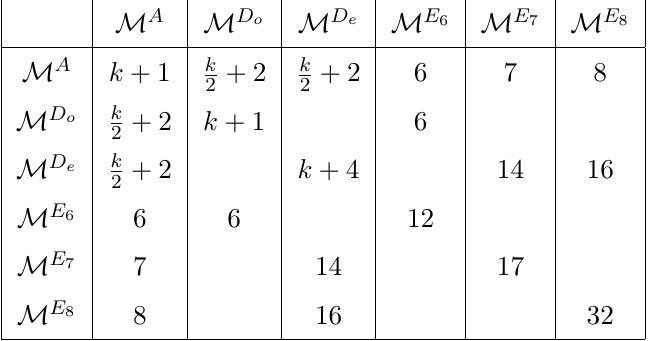
Table 3 . Traces of products of modular invariants for the su (2) k WZW models. Interfaces in the SU(2) Chern-Simons theory correspond to such modular invariants. Equivalently, they compute k the ground state degeneracy of the effective 2d TFT on the torus when the IR and UV theories correspond to one of these